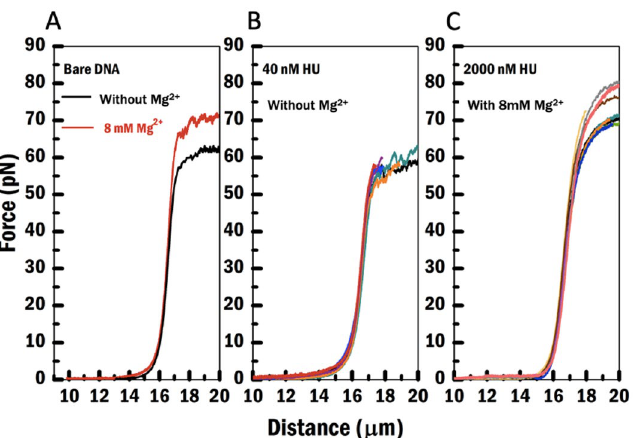
Figure 2. Force-Distance curves of ( A ) bare dsDNA without and with 8 mM Mg 2+ containing buffer, ( B ) multiple representative HU–DNA complexes without Mg 2+ at a concentration of 40 nM HU, and ( C ) multiple representative HU–DNA complexes with 8 mM Mg 2+ at a concentration of 2000 nM HU. The data shown in ( A ) were acquired in a protein-free channel, that of ( B ) and ( C ) in a channel containing HU protein.